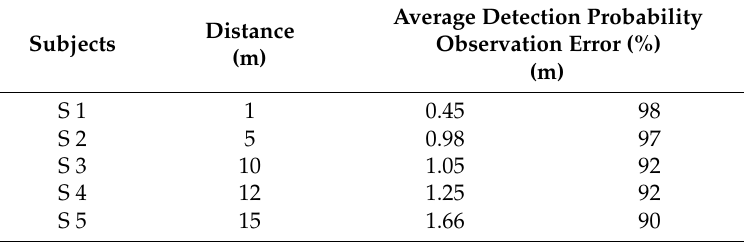
Table 5. Error observation vs distance for BT